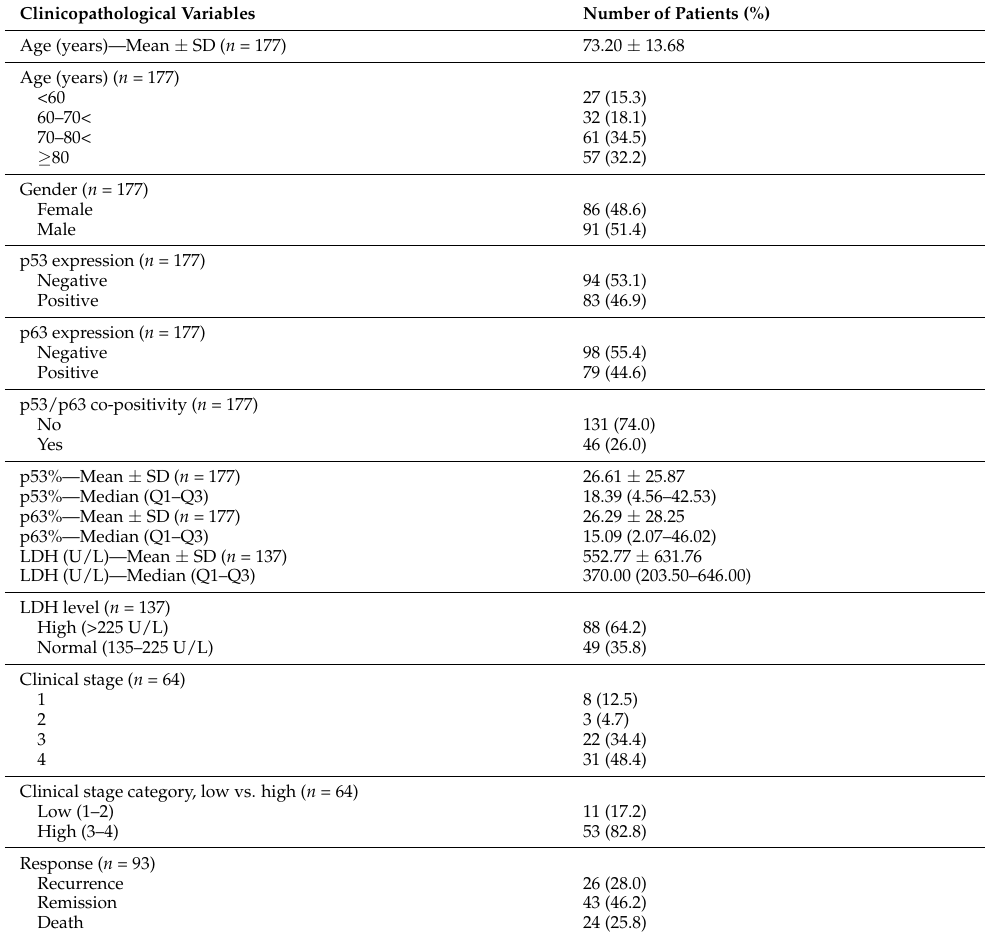
Table 1. Clinicopathological characteristics of patients ( N =